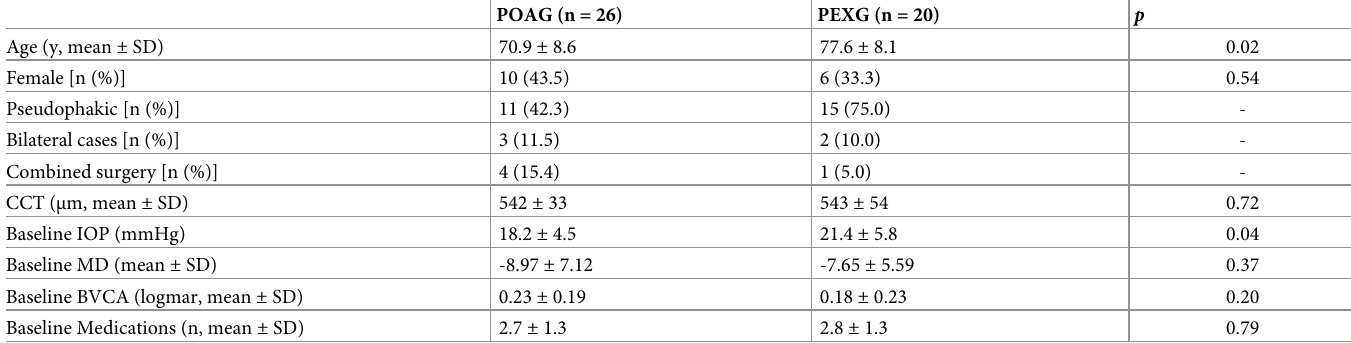
Table 1. Demographic and clinical data.